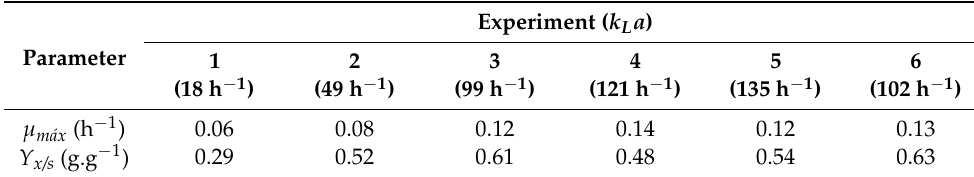
Table 4. Parameter values of R. mucilaginosa CBMAI 1528 cultivation carried out in bioreactor under different k L a